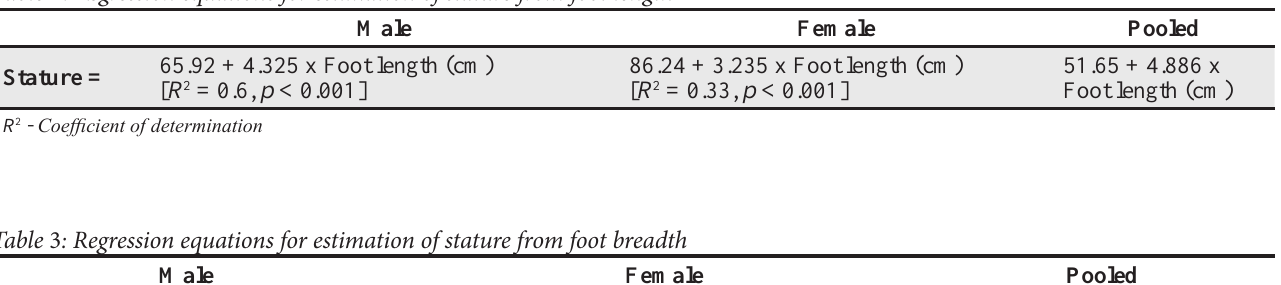
Table 3 : Regression equations for estimation of stature from foot Male Female Pooled Stature =